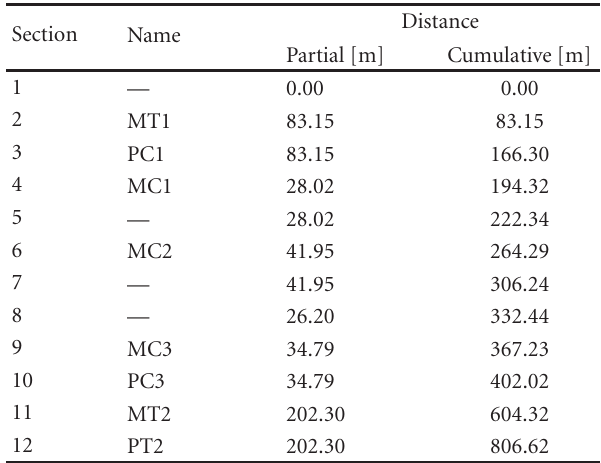
Table 3: Road sections